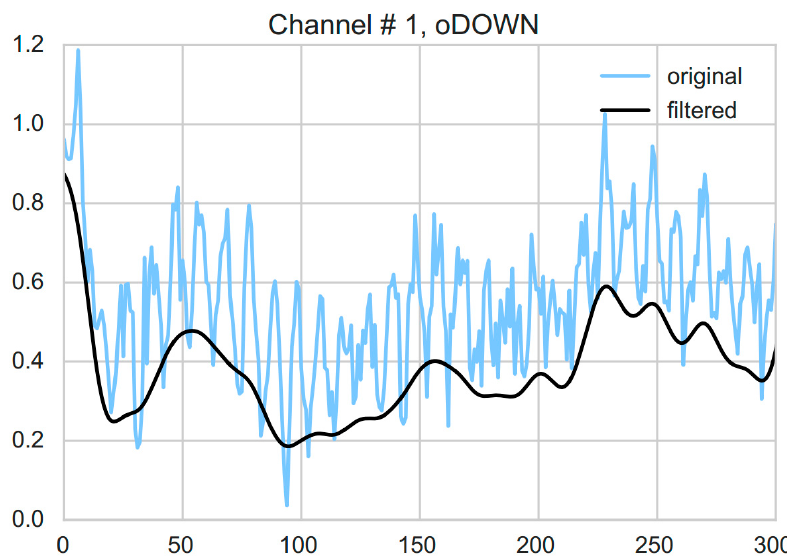
Figure 3. An example showing both raw (blue) and filtered (black) HHb response corresponding to the first channel of one of the sub-blocks i.e., overt DOWN of one of the subjects. Filtering was performed by first removing the linear trends from the response and then using a fourth order Butterworth filter with a cut-off frequency of 0.5 Hz to account for the effects of the cardiac pulse.